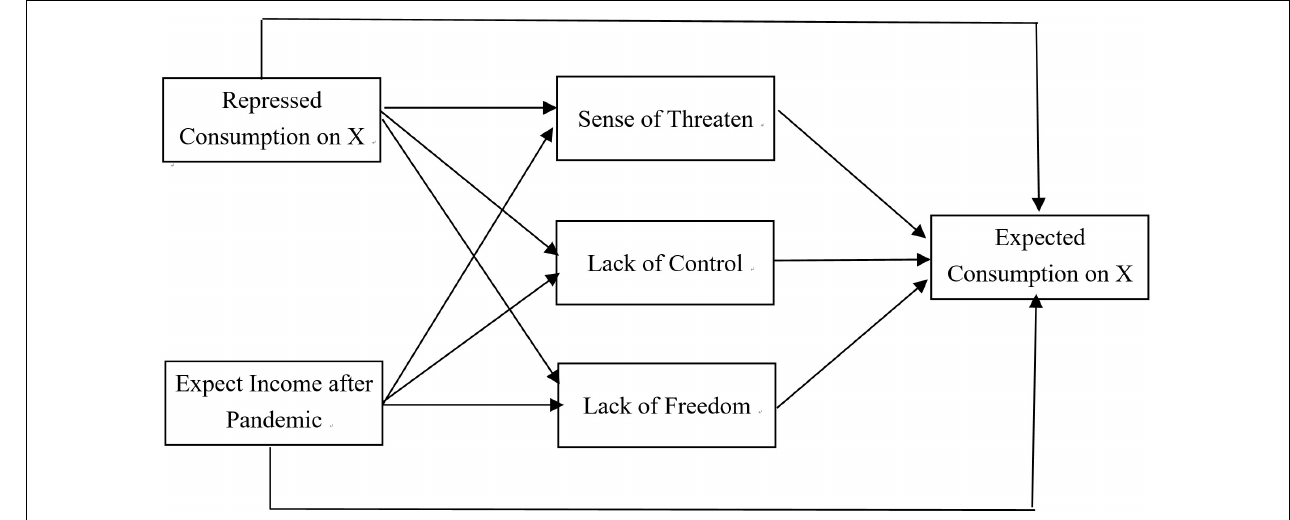
FIGURE 1 | The empirical research